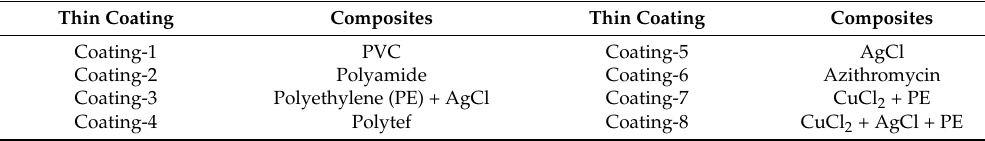
Table 2. Composition of the eight sensor coatings in the sensor array.